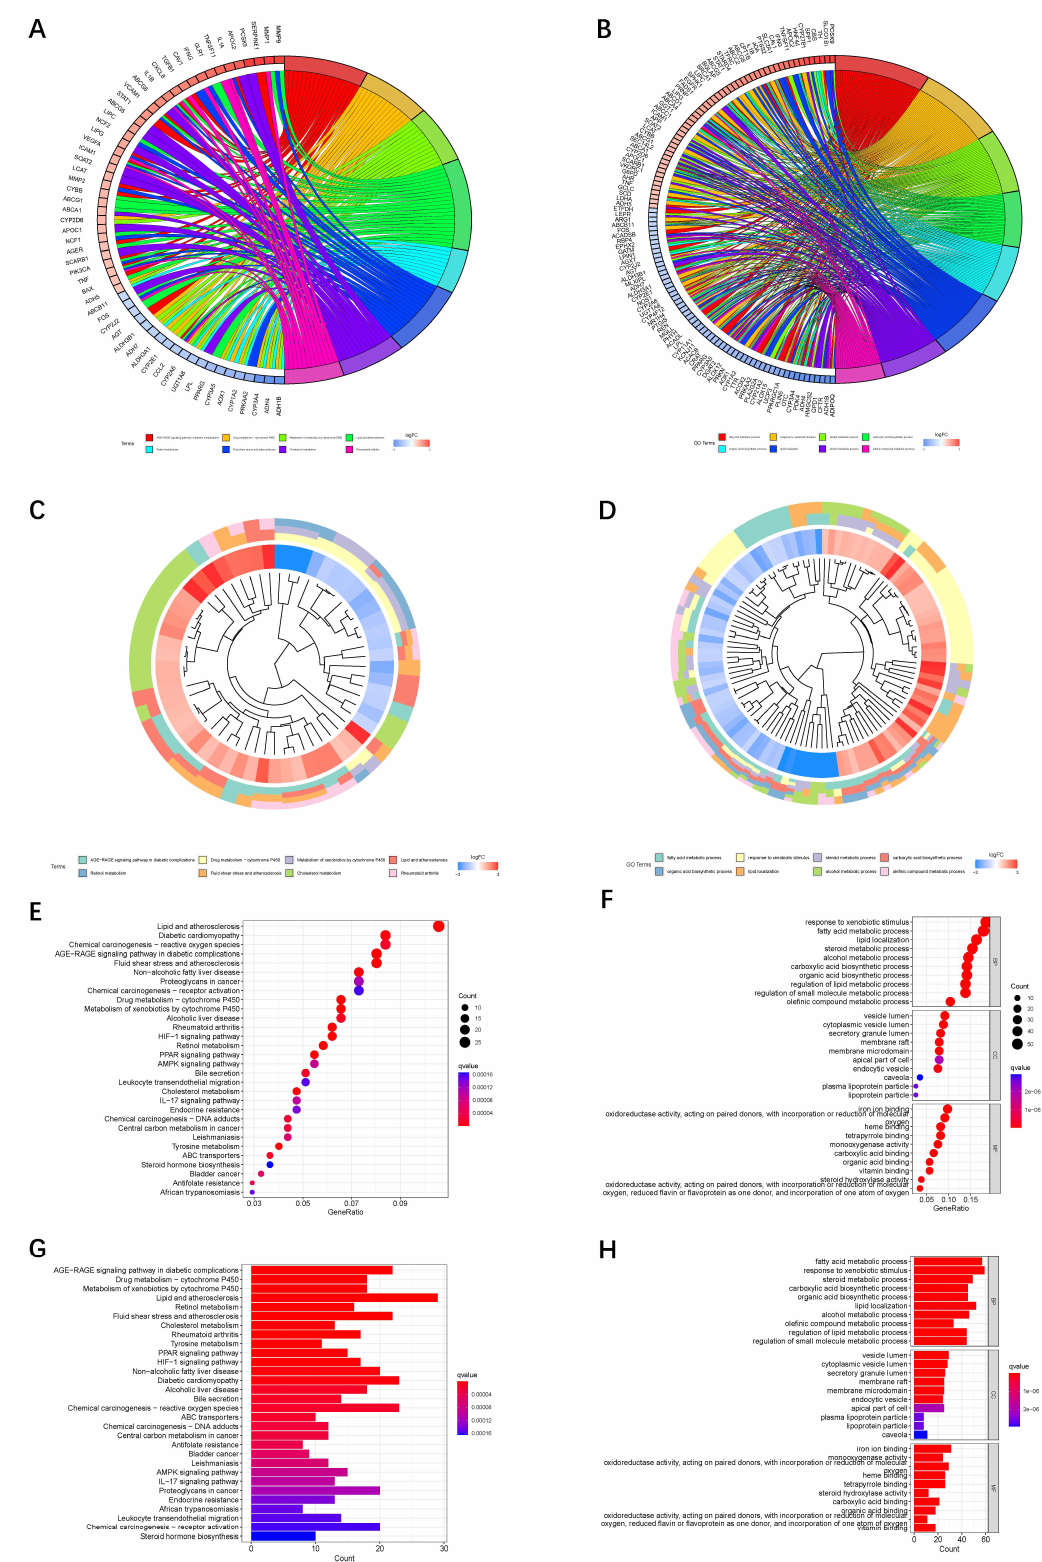
Figure 2. KEEG and GO analyses of the differentially expressed genes between two samples. ( A , C , E , G ): KEGG analysis of the differentially expressed genes in two samples. ( B , D , F , H ): GO analysis of the differentially expressed genes in two